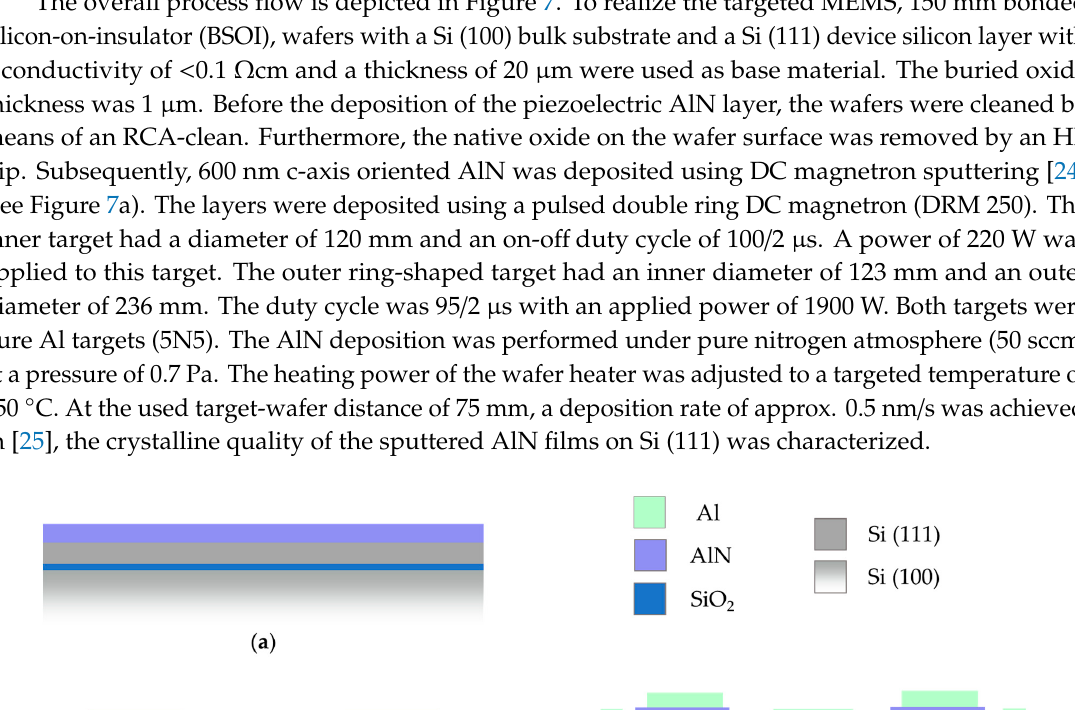
Figure 8. Microscope image of the spring structures of a fabricated micromirror of Design 2.